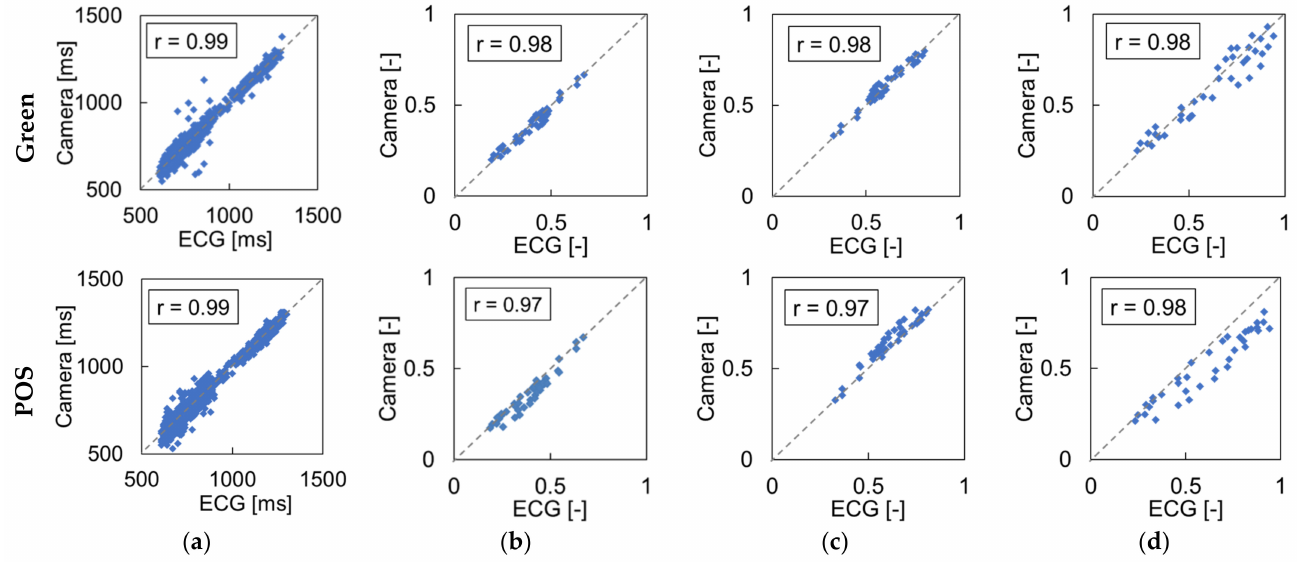
Figure 5. Comparison between rPPG and ECG in RRI and HRV metrics, LF, HF, and LF/HF at 30 fps. The horizontal axis is the result obtained by the ECG, and the vertical axis is the result obtained from the camera. The upper four graphs show the results of the Green method and the lower four graphs show those of POS method: ( a ) RRI, ( b ) LF, ( c ) HF, and ( d ) LF/HF.